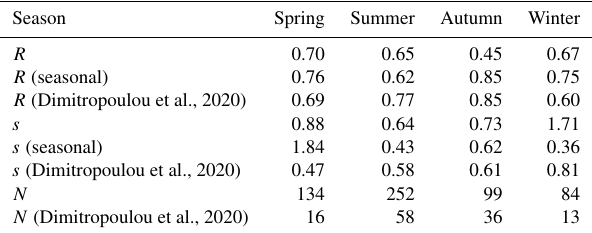
Table 4. Summary of the regression analysis parameters (e.g., cor- relation coefficient, R , and slope, s ) and the number of data points ( N ) derived in the present study during only 1 year of observa- tions (i.e., number of pixels) and in Dimitropoulou et al. (2020). Please note that R (seasonal) and s (seasonal) correspond to SEAS in Fig.